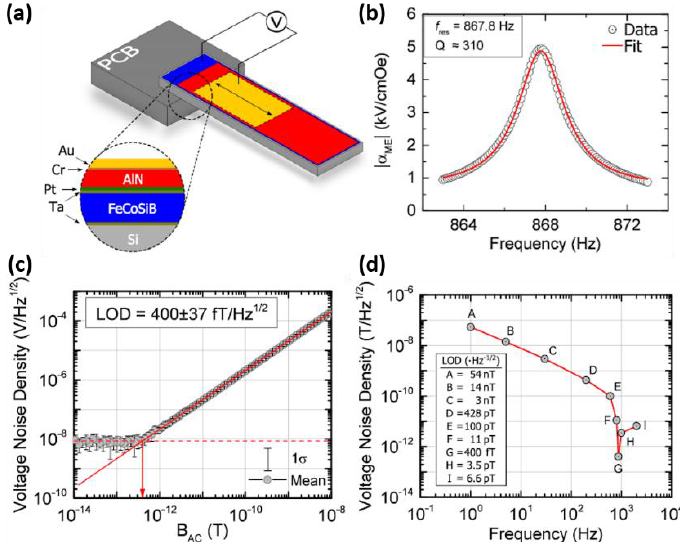
Figure 4. ( a ) Schematic illustration of the cantilever-based thin-film magnetic sensor using inversed bilayer ME heterostructures. ( b ) ME coefficient as a function of frequency ( 𝐻 𝑎𝑐 = 1 × 10 −7 𝑇 and 𝐻 𝑏𝑖𝑎𝑠 = ±2.1 × 10 −4 𝑇 ). The electromechanical resonance frequency was measured to be 867 Hz and the quality factor is determined as 310 from the applied Lorentzian fit. ( c ) Averaged LoD plot with error bars that indicate standard deviation. ( d ) The measured ME sensor’s LoD with respect to frequency. Reproduced with permission from [71]. Copyright [2016], American Institute of Physics.